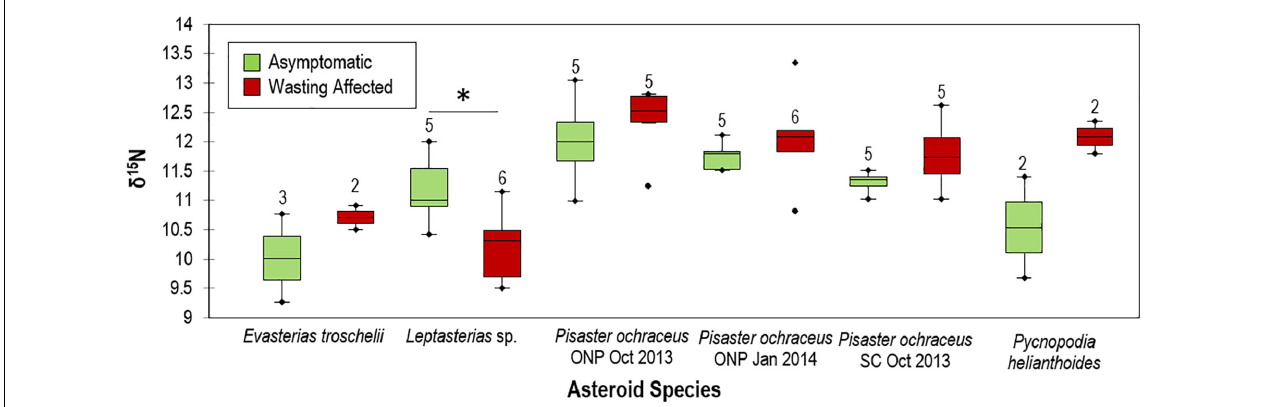
FIGURE 11 | Comparison of grossly normal and wasting δ 15 N values between species. ONP = Starfish point, Olympic national park and SC = Davenport, Santa Cruz, CA. * indicates p < 0.05. Numbers above box plots indicate n of specimens used in